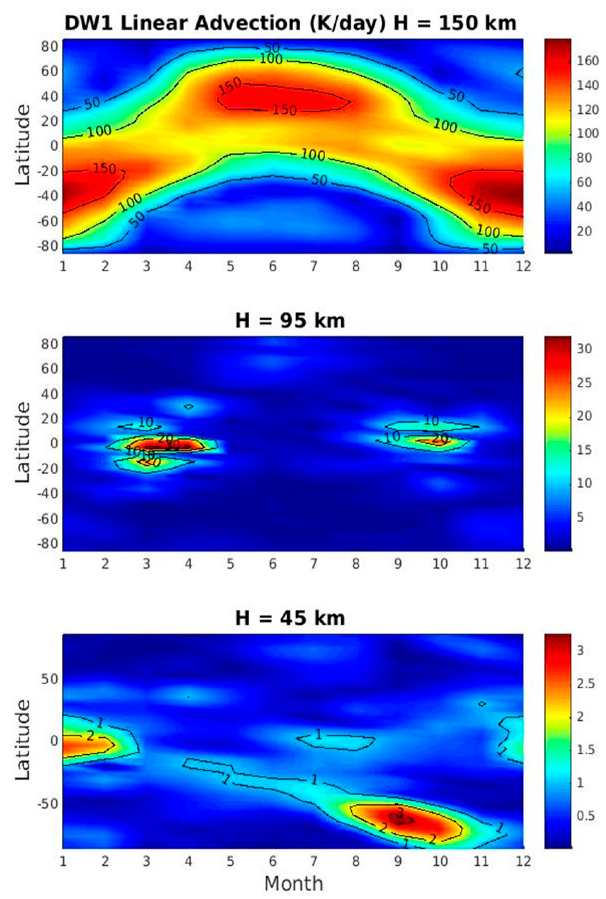
Figure 5. Seasonal variations of the linear advection term (wave-mean flow interaction) (K/day) on the right-hand-side ( RHS ) of thermodynamic budget Equation (1) for DW1 at 45, 95 and 150 km.